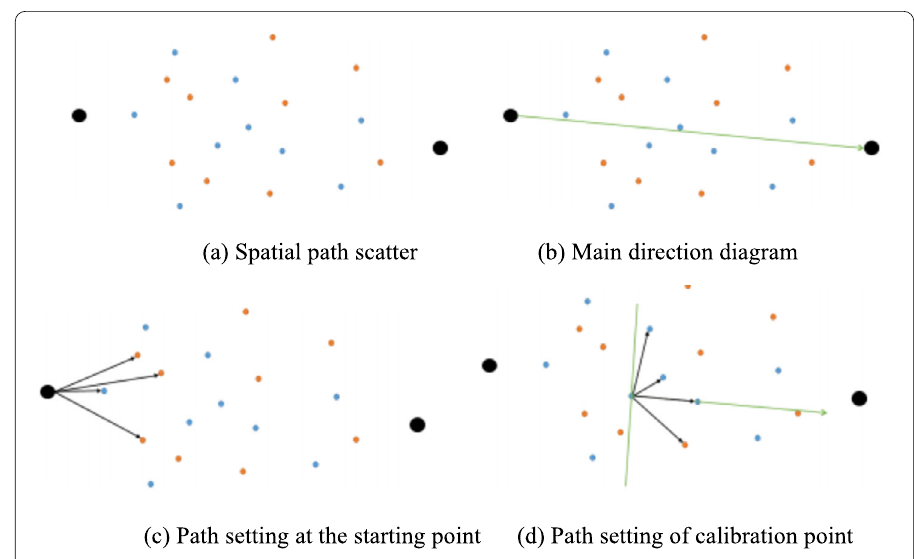
Figure 2 Schematic diagram of the directed